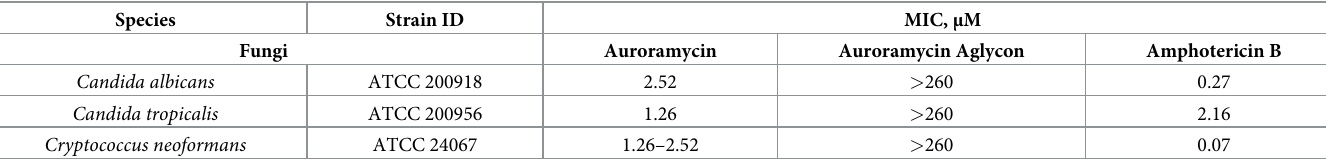
Table 1. Antifungal activity of auroramycin.